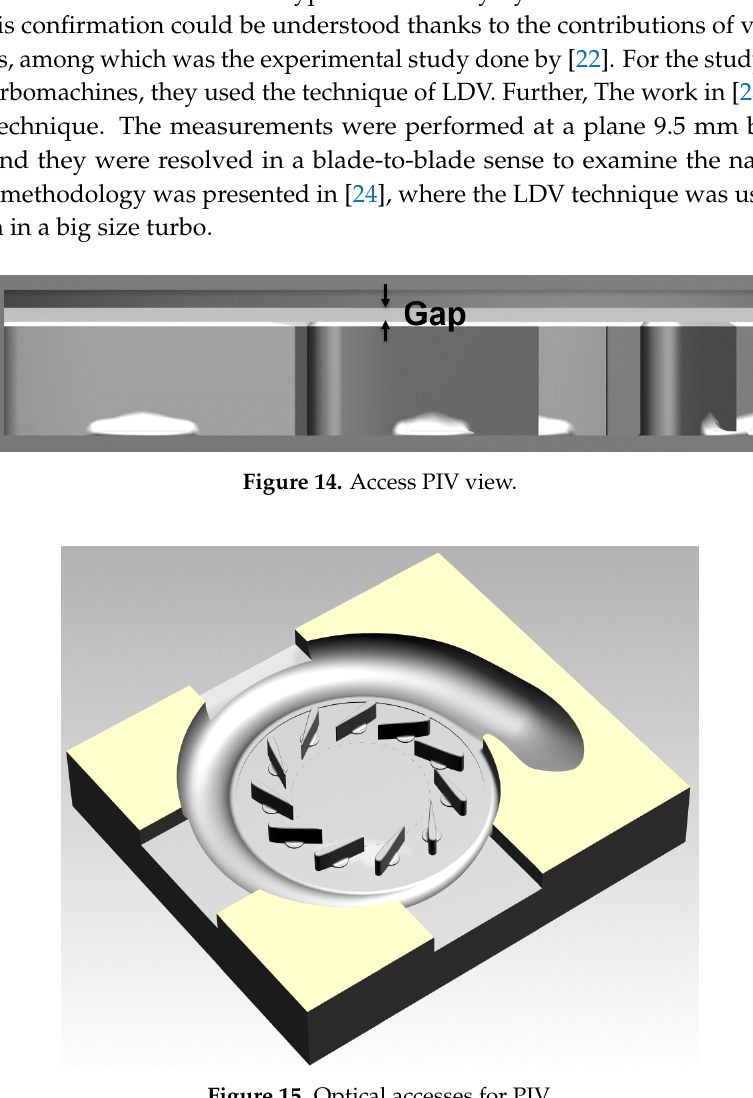
Figure 15. Optical accesses for